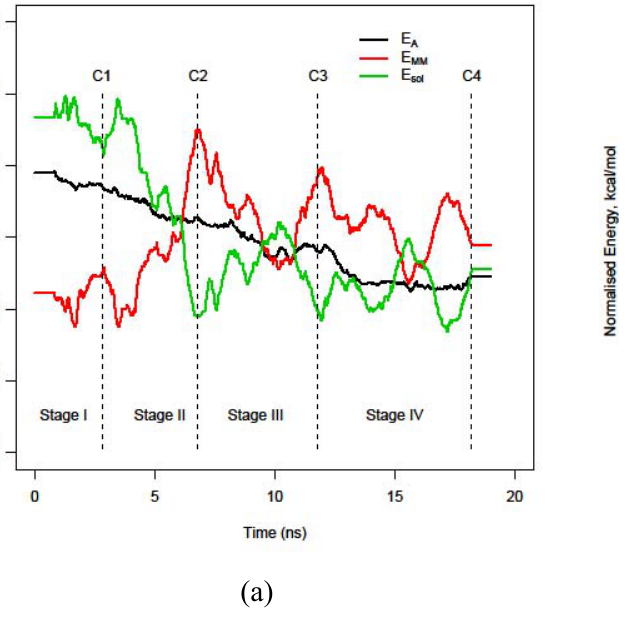
= E + E B MM,A sol,A